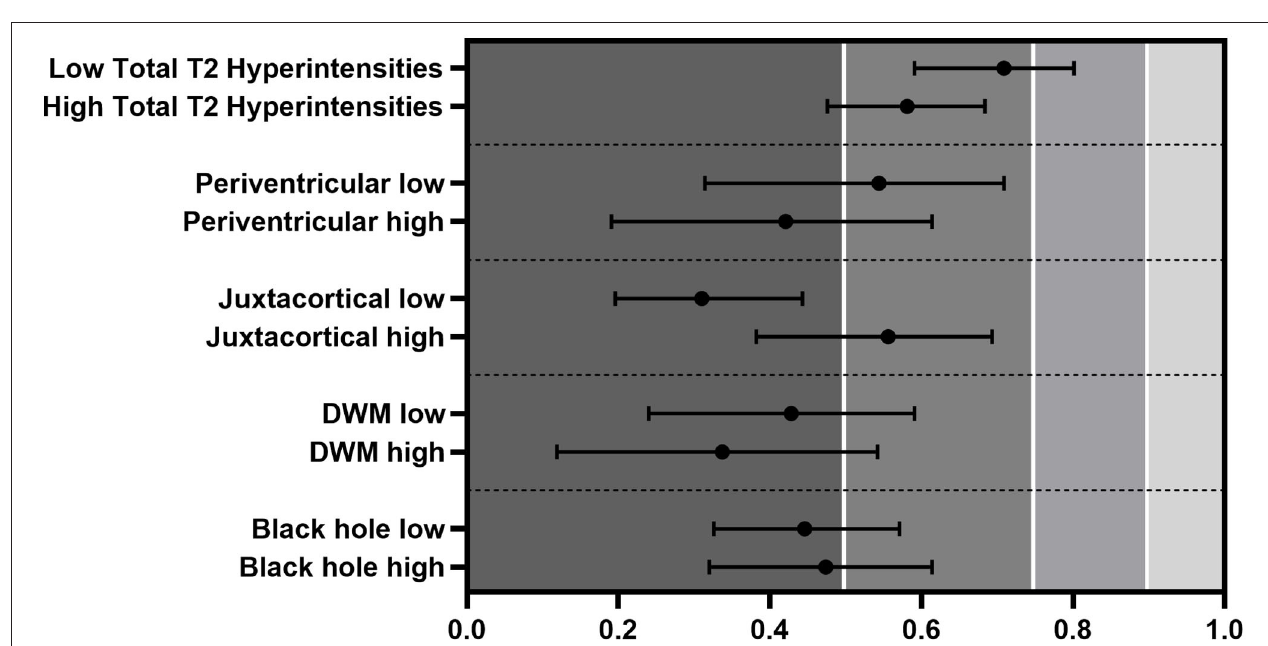
FIGURE 3 | ICC differences between low- and high-lesion counts evaluated by every rater. Error bars represent CIs.